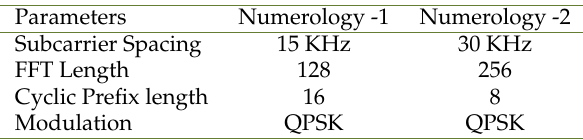
Table 1. Simulation parameters [20]